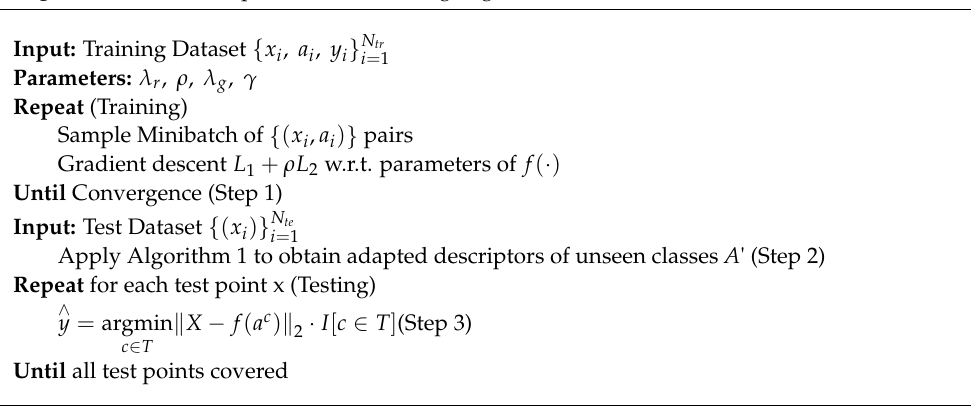
Algorithm 2 : Three-step Zero-shot Learning Algorithm